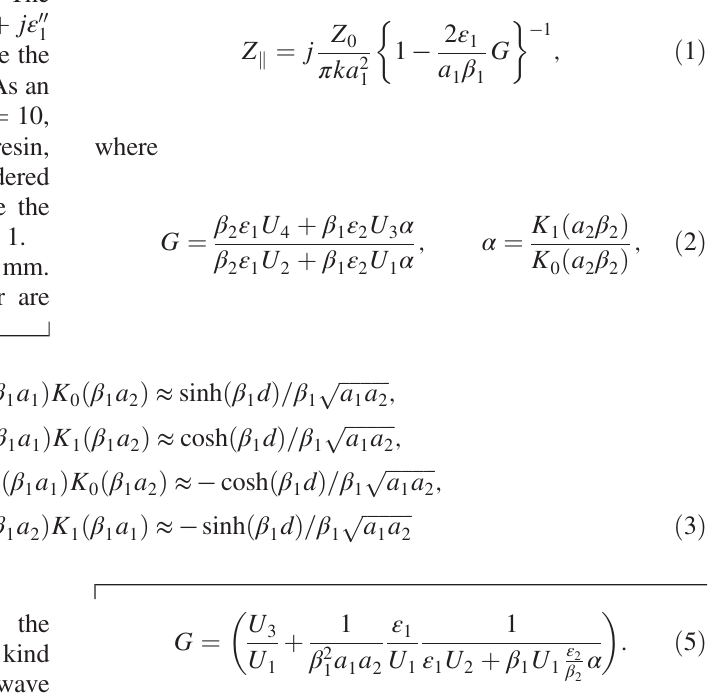
ffiffiffiffiffiffiffiffiffiffiffiffiffiffiffiffiffiffiffiffiffiffi p 1 − ε